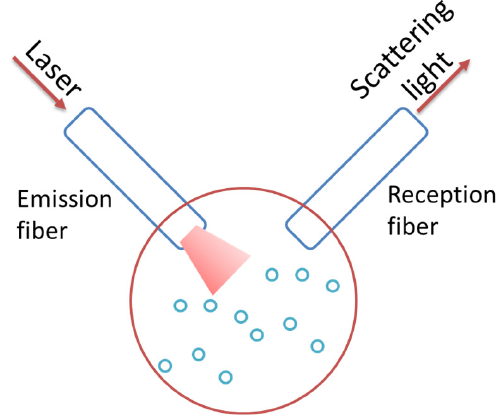
Figure 3. Schematic diagram of in situ DLS configuration using optical fiber.